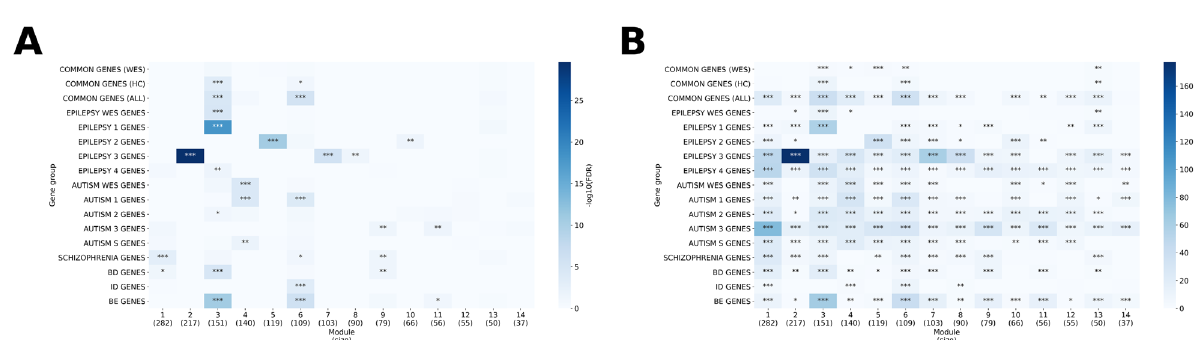
Figure 3. Summary of multiplex network construction and network modules. ( A ) In the epilepsy-autism gene network there are a total of 1707 genes represented, including 999 epilepsy-associated genes and 913 autism- associated genes (205 genes are shared). ( B ) Using the 1707 genes a multiplex gene network was created. One layer of the multiplex network represents protein–protein interactions (PPIs) between the genes retrieved from the STRING database. The other layer was created using gene-phenotype relations retrieved from the Phen2Gene knowledge base. A multiplex version of the well-known Louvain algorithm was applied on the multiplex network to generate modules taking both layers of the network into consideration. The regular Louvain algorithm was also applied to each layer separately to generate modules using only one layer. ( C ) The figure plots the size of the 30 largest modules generated from the PPI network layer, the phenotype network layer, and the multiplex network.